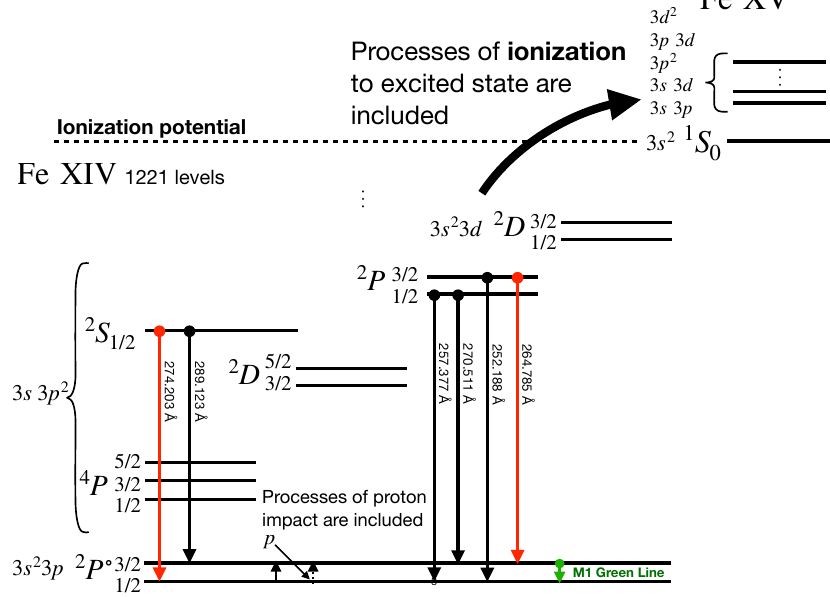
Figure 1. Schematic of lowest 12 levels of Fe XIV. Green line denotes forbidden M1 transition between two fine-structure levels of ground state. Proton-impact excitation and electron-impact ionization processes to excited states of Mg-like iron ions are included in our